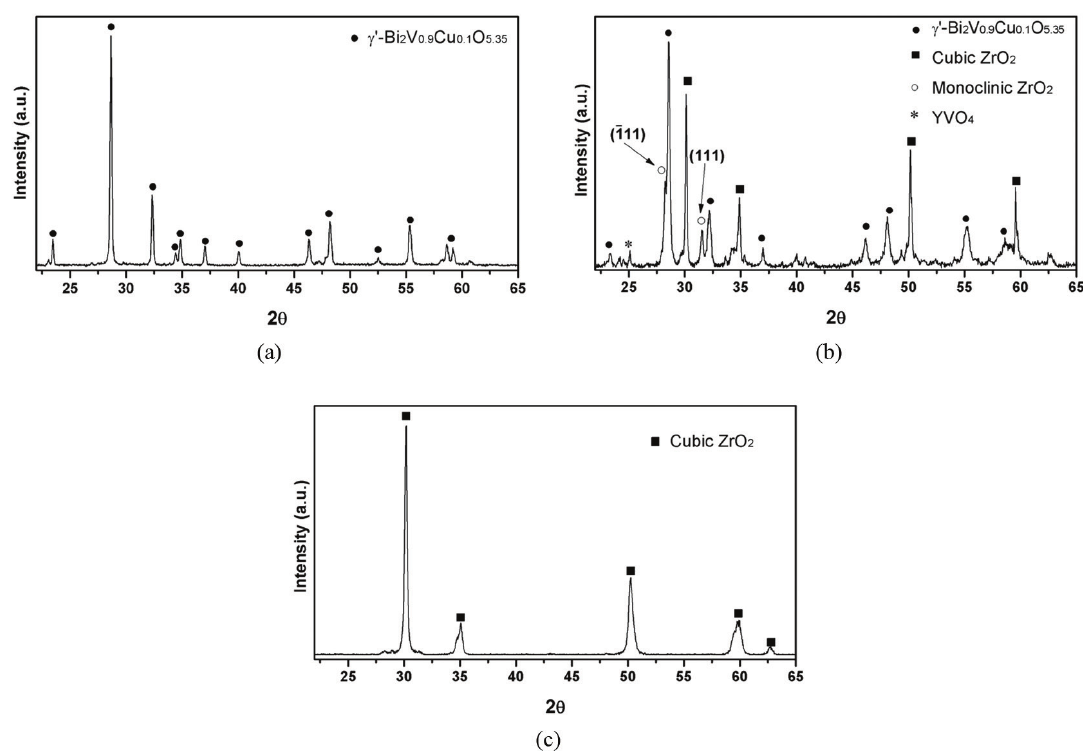
Figure 3. X-ray diffraction patterns for (a) BICUVOX.10, (b) 50B/50Z8 and (c) 8YSZ. Crystallographic planes of ZrO polymorph are shown in (b).